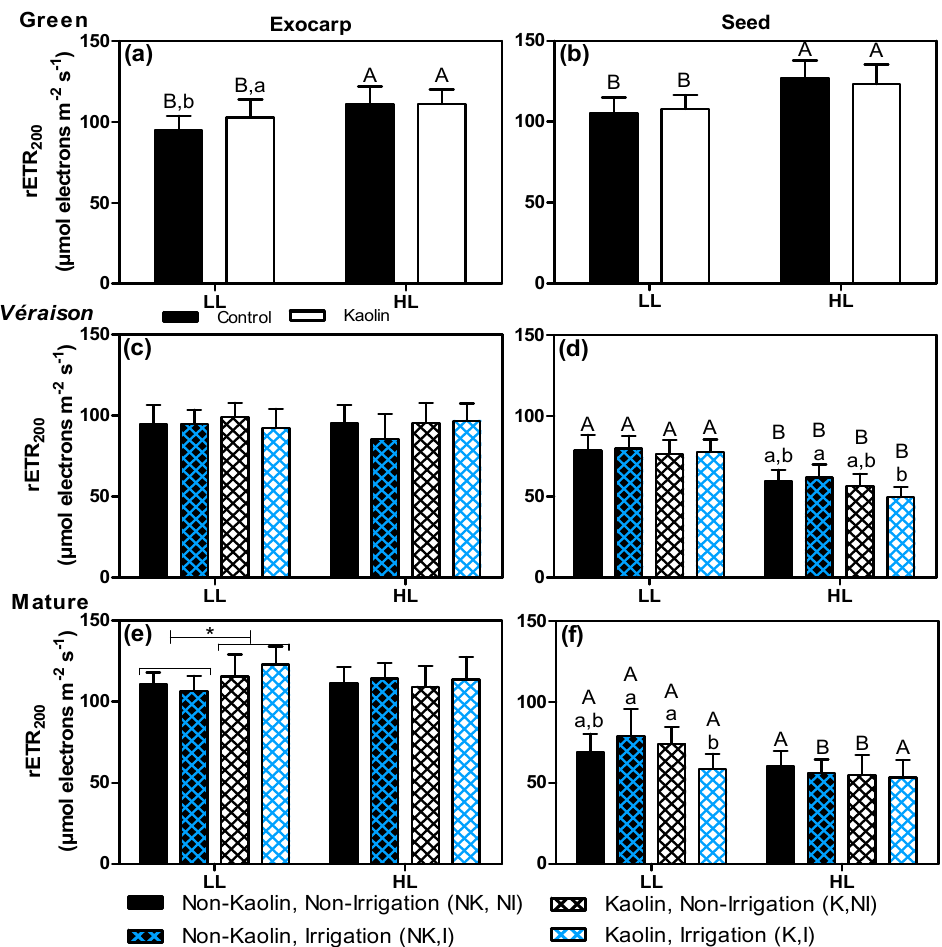
Figure 6. Mean values ( n = 12–24 berries, + SD) of relative rate of electron transport through PSII at 200 µmol photons m − 2 s − 1 (rETR 200 ). All the microclimate conditions, treatment combinations and statistical information are the same as in Figure 5.